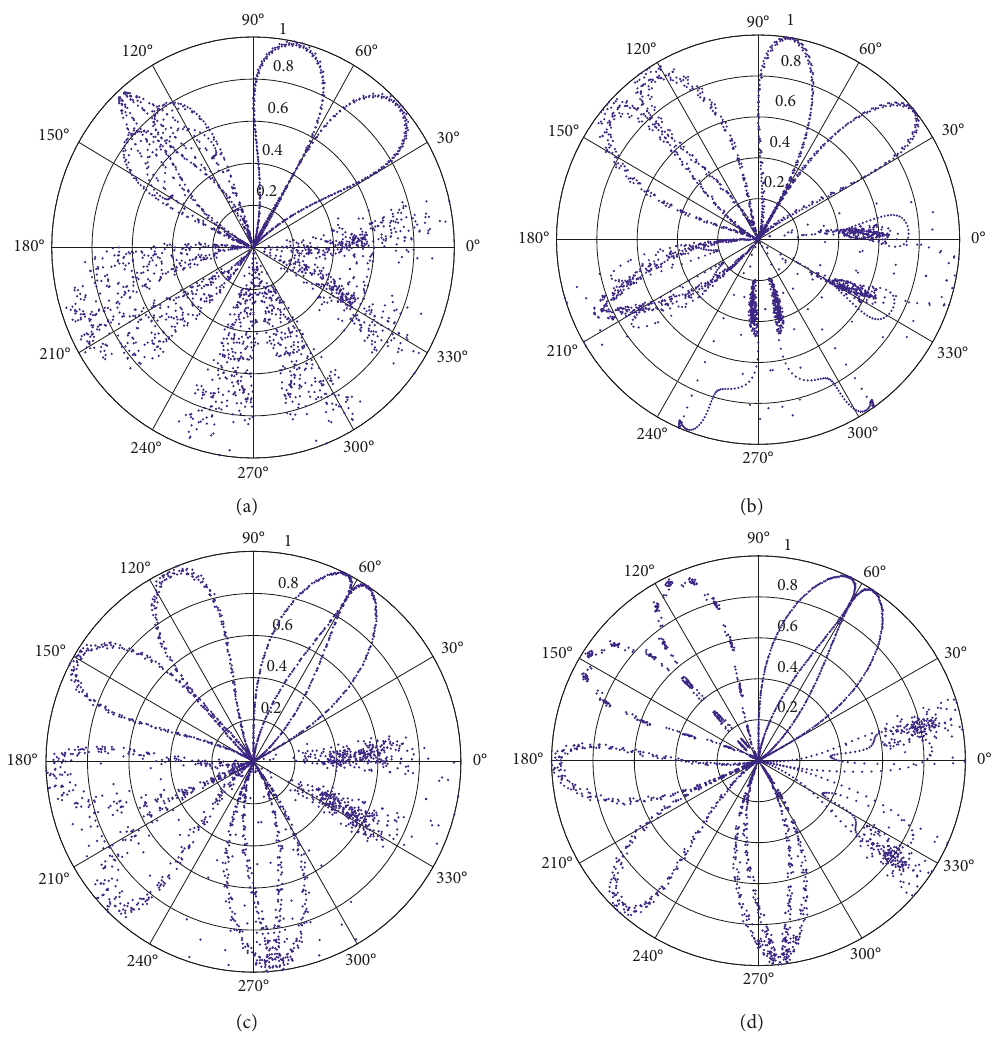
Figure 10: SDP image with illusive components. (a) Imbalance. (b) Whirl. (c) Misalignment. (d)